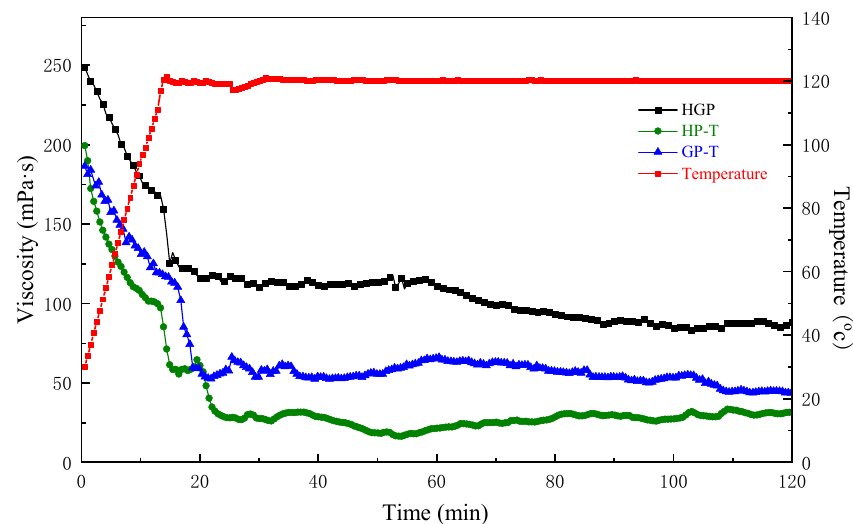
Figure 13. Rheological properties of copolymers HGP, HP-T, and GP-T at 120 °C.